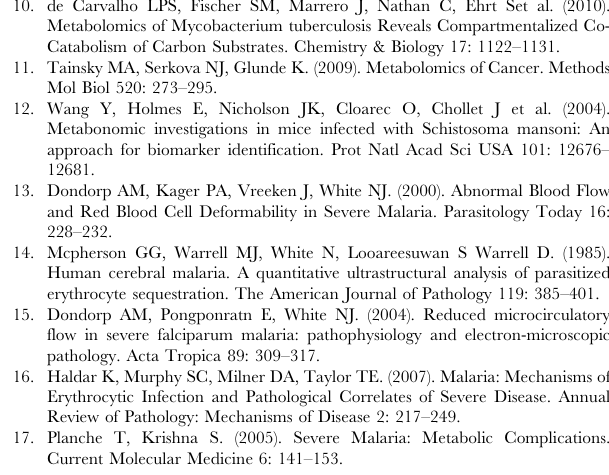
plot, red dots- uninfected control animals, black dots- peak